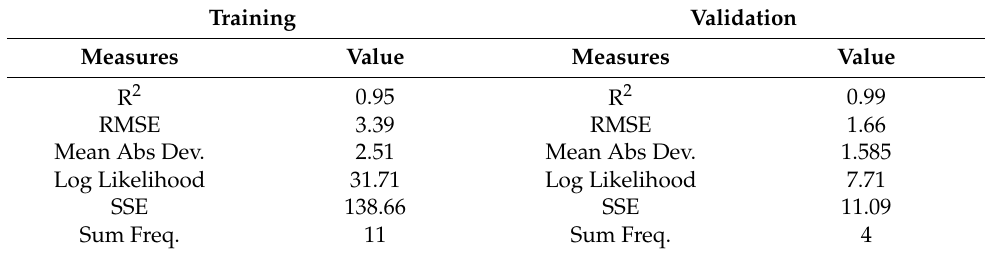
Table 7. Sensitivity of the training and validation parameters.